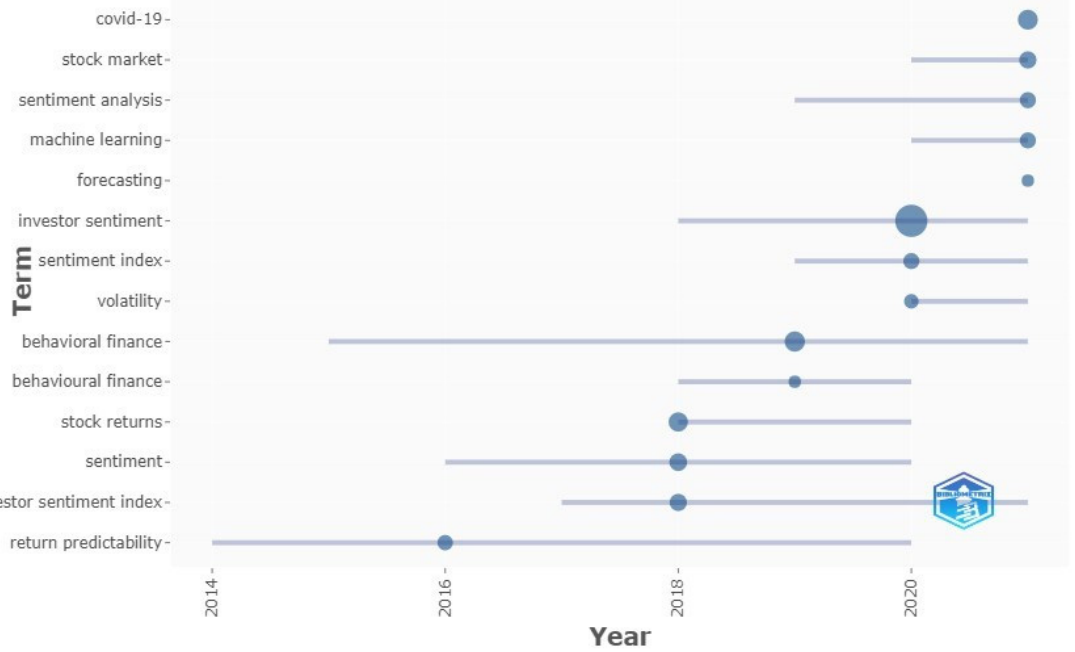
Figure 11. Topic trends.